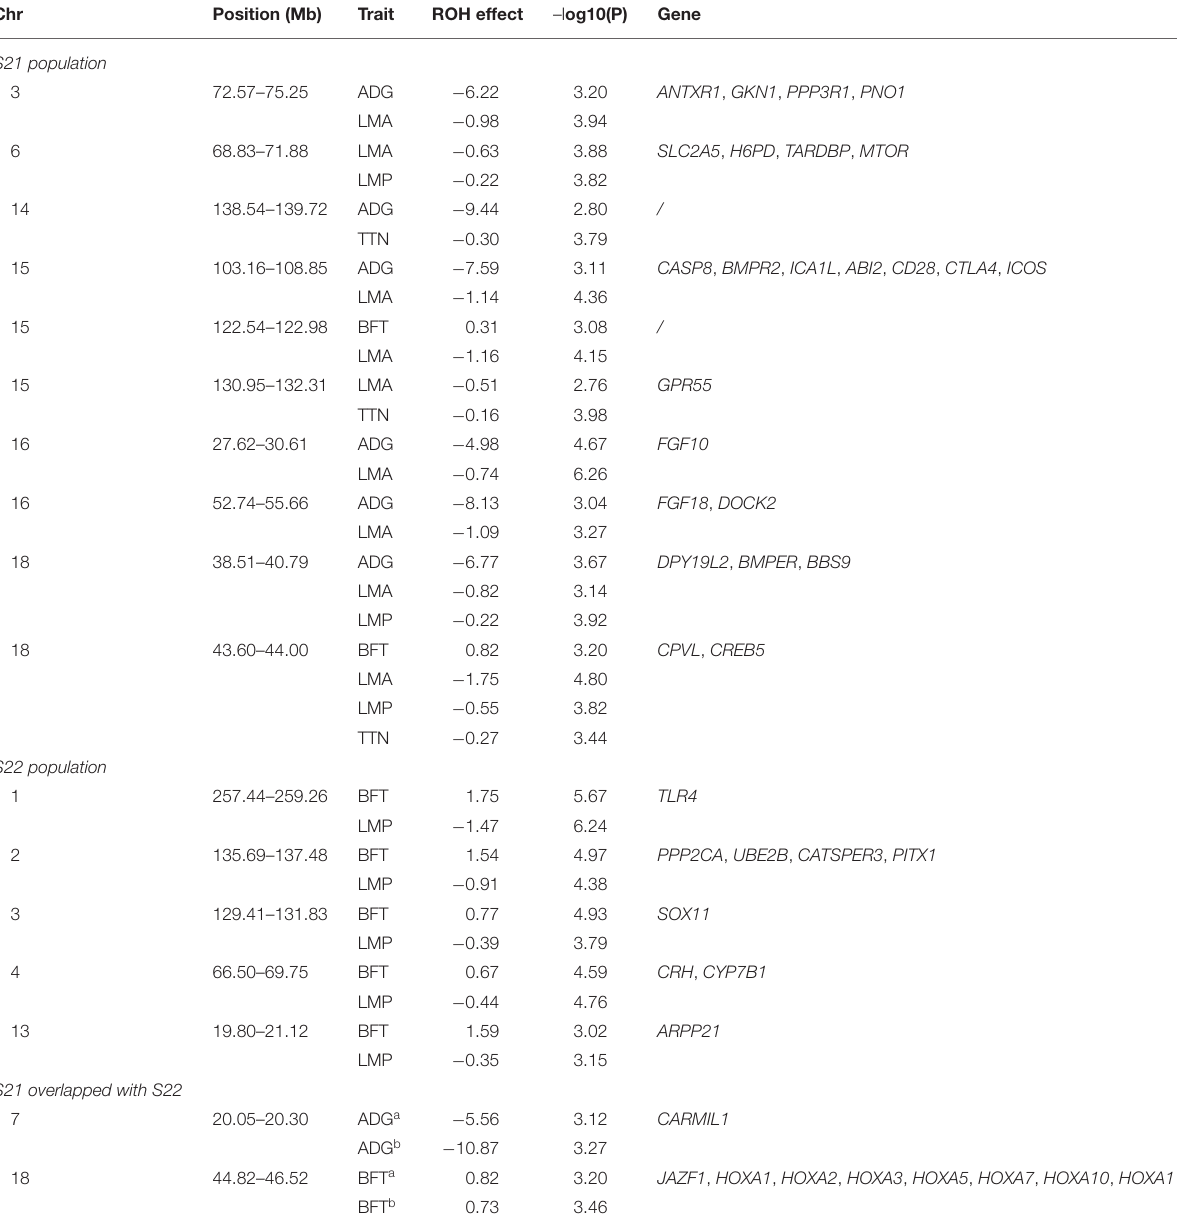
TABLE 2 | Unfavorable ROHs shared by economic traits and two Duroc